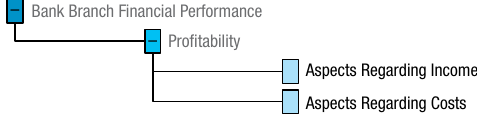
Fig. 2. Financial performance measures tree